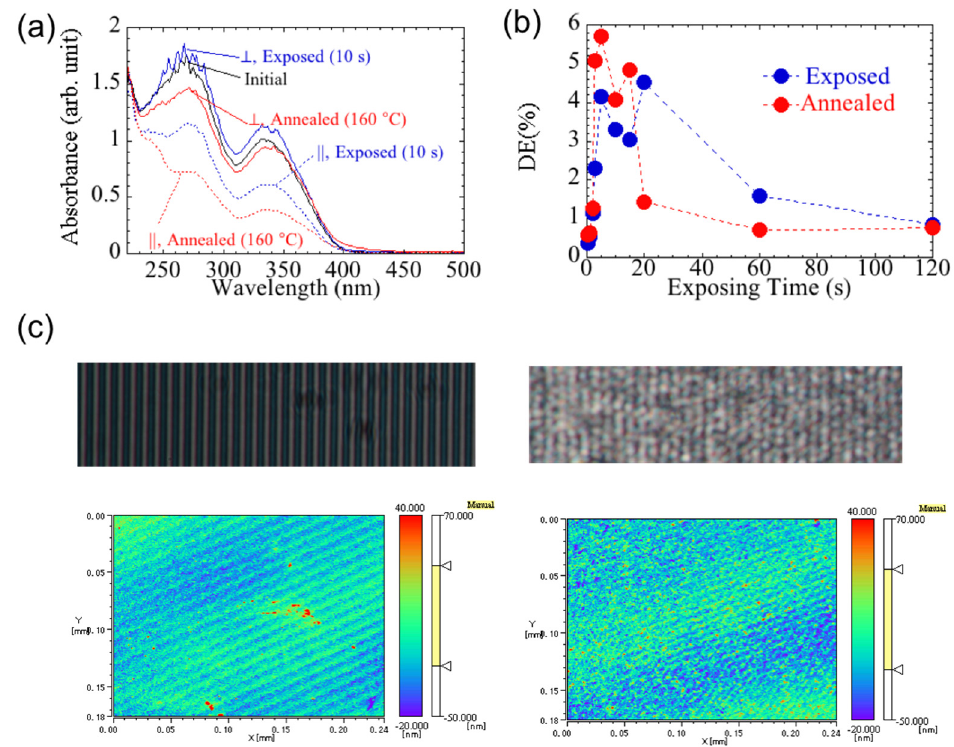
Figure 5. ( a ) Polarized absorption spectra of P1 film with a thickness of 460 nm after spin-coating, irradiation with linearly polarized UV-laser, and annealing at 160 ◦ C for 10 min. The spectra are color-coded as black for initial, blue for irradiation, and red for annealing, respectively. The absorption spectra for the directions parallel and perpendicular to the polarization direction of the laser beam are indicated as solid and dashed lines, respectively. ( b ) Variation in +1st diffraction efficiency of P1 film with a thickness of 460 nm as a function of exposure time (solid line) and 1st diffraction efficiency of P1 film after thermal annealing at 160 ◦ C. ( c ) POM image ( top ) and surface profile ( bottom ) of P1 film with thickness of 460 nm after irradiation ( left ) and thermal annealing ( right